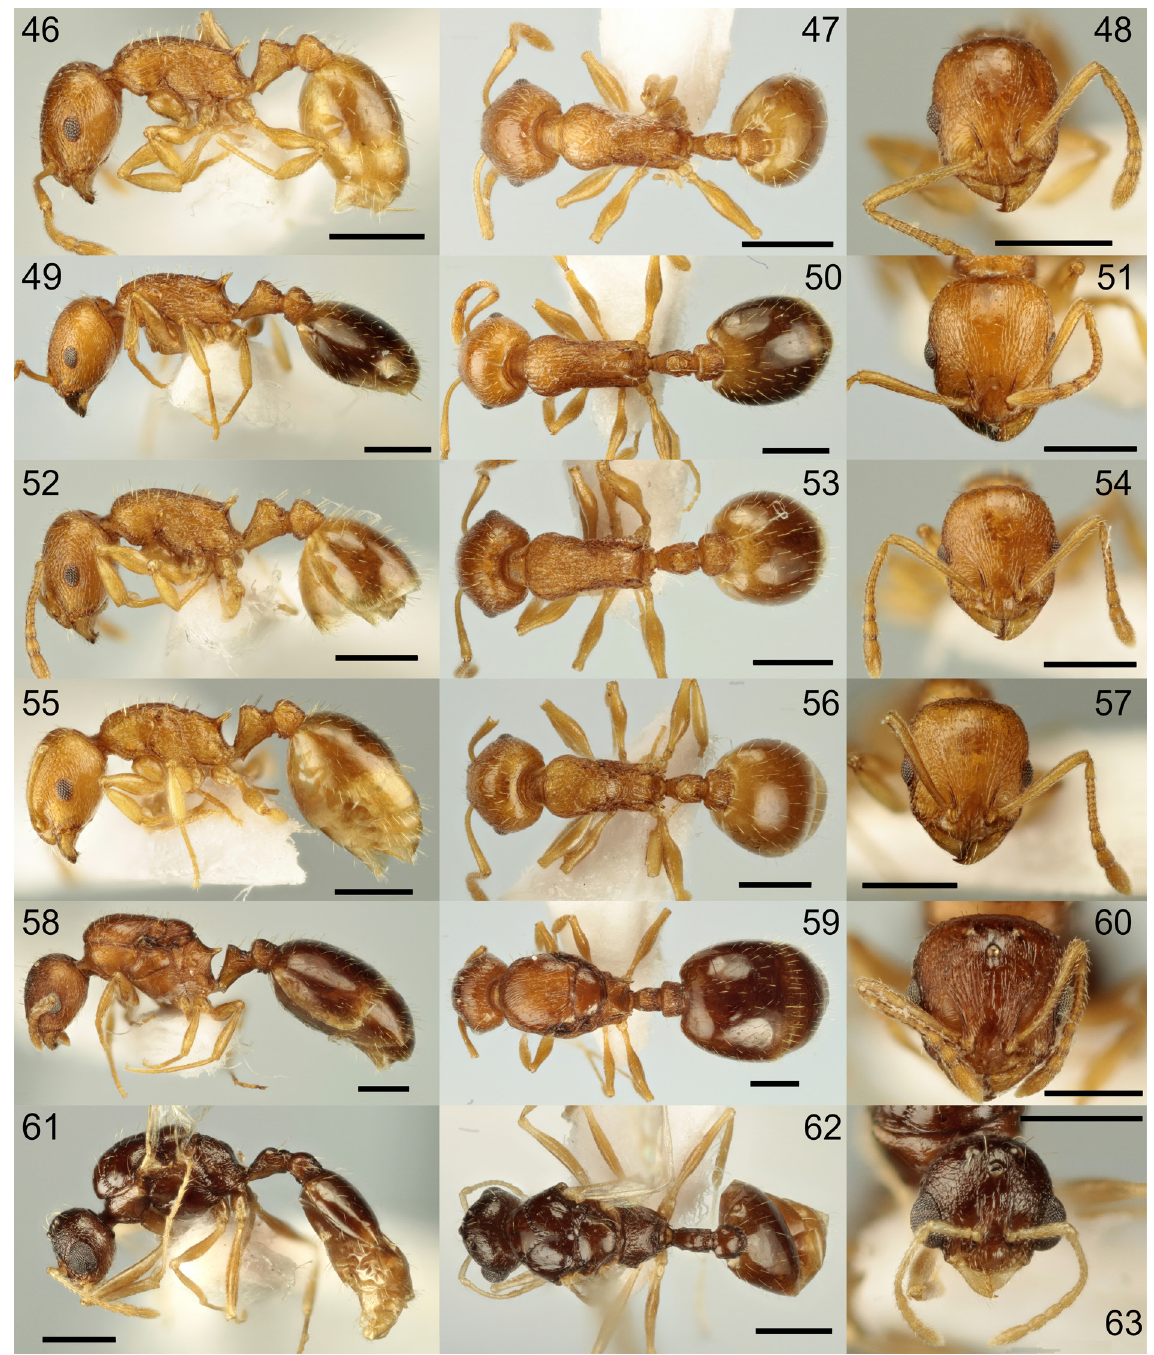
Figs 46–63. Specimens of Temnothorax poldii Alicata, Schifani & Prebus sp. nov. in lateral (left), dorsal (center) and head view (right). Photos by Enrico Schifani, available on www.antweb.org, specimen identifiers in parentheses. 46–48 . Holotype worker from Monte Arso (Etna, Sicily) (ANTWEB1041545). 49–51 . Worker from Vallone Madonne degli Angeli (Madonie, Sicily) (ANTWEB1041546). 52– 54 . Paratype worker from Monte Ruvolo (Etna, Sicily) (ANTWEB1041547). 55–57 . Worker from Monte Manfrè (Etna, Sicily) (ANTWEB1041548), with ergatogynes characters in the mesosoma. 58– 60 . Paratype queen from Monte Arso (Etna, Sicily) (ANTWEB1041549). 61–63 . Paratype male from Monte Ruvolo (Etna, Sicily) (ANTWEB1041550). Scale bars = 0.5